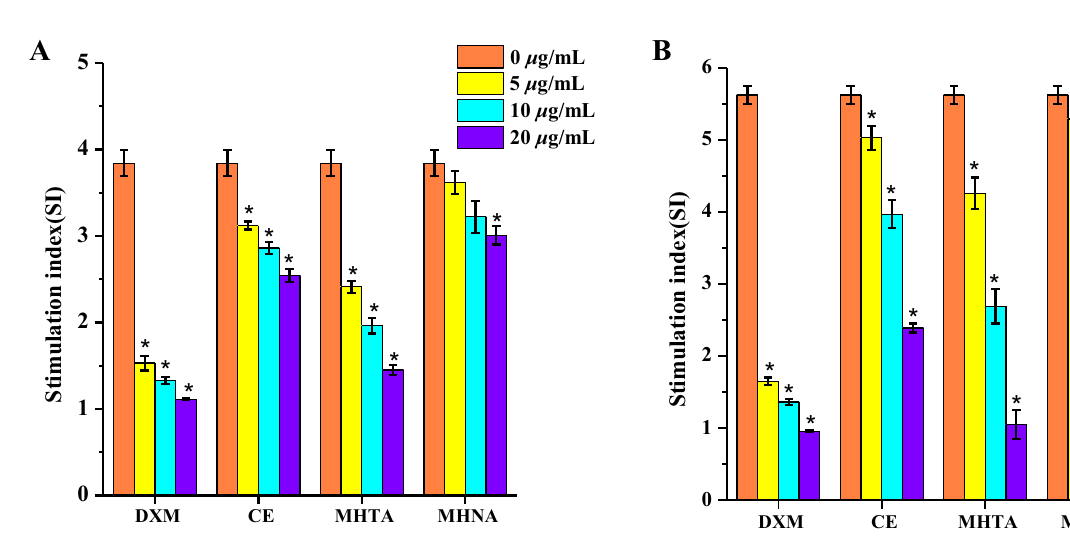
trol. The values are presented as mean ± SD of triplicates. * p < 0.05, means significant difference from the control group (0